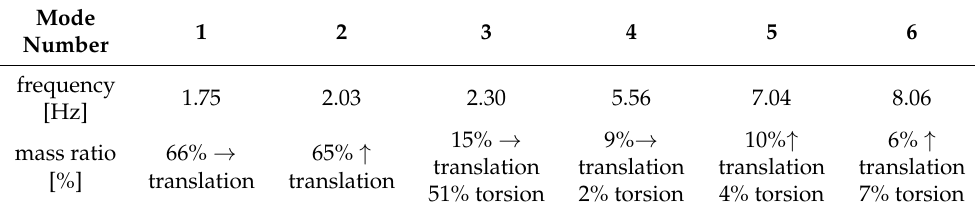
Table 2. Eigen modes of over ground structure, ETABS